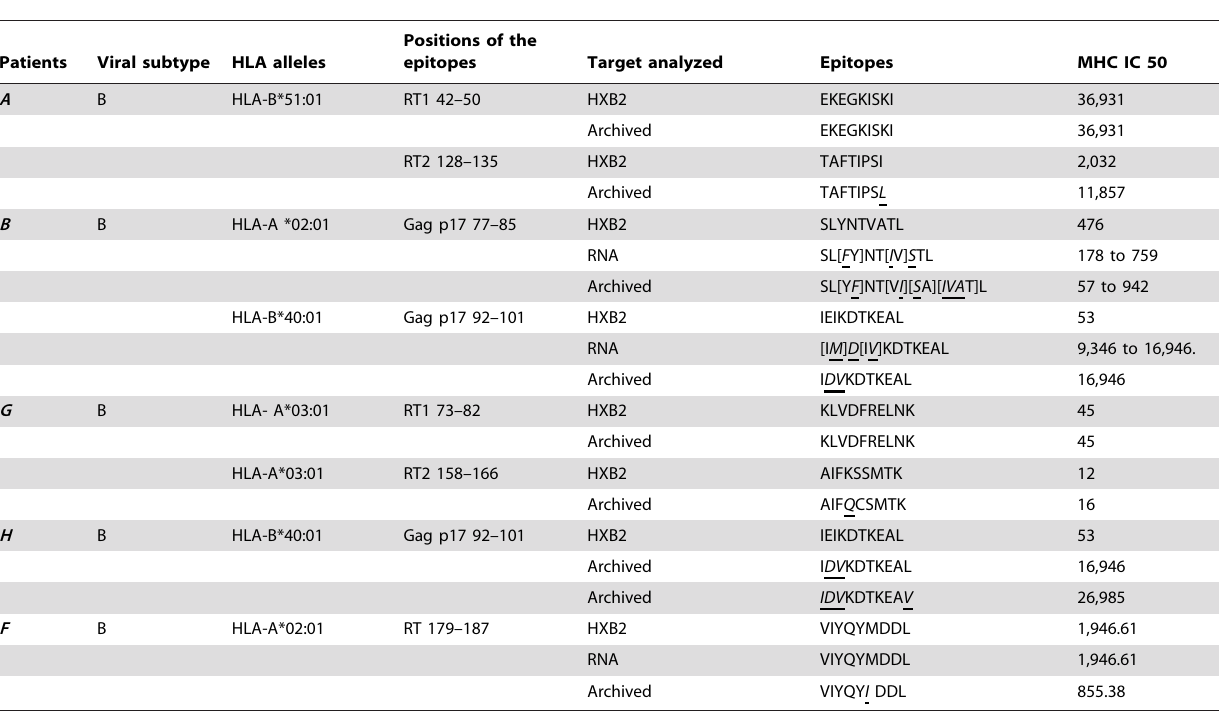
Table 3. Potential CTL reactivity against viral (RNA) and/or archived proviral DNA epitopes according to HLA I alleles.